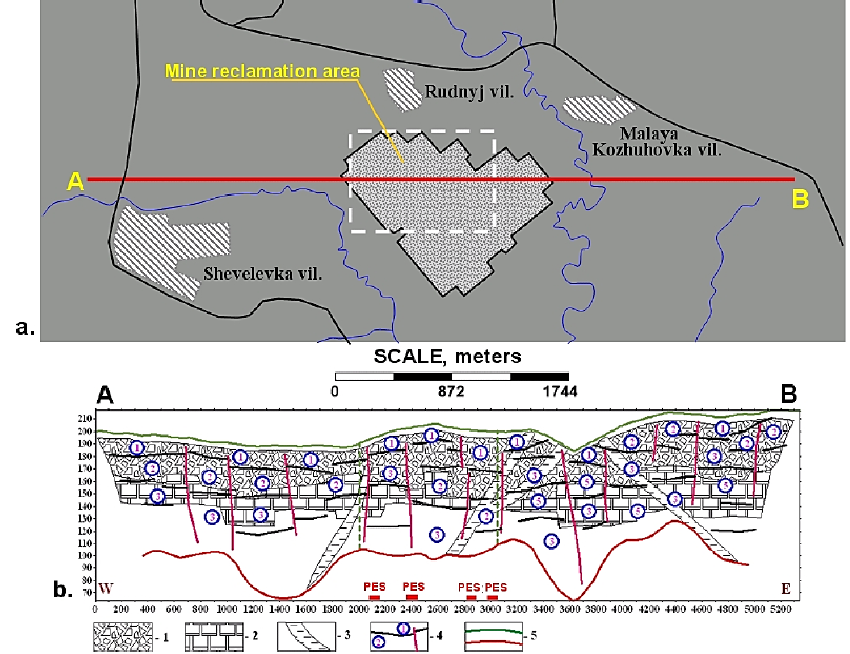
Figure 6. The example of leading deep geostructural reconstruction along AB profile: ( a ) geographical reference of AB profile with regard to the boundaries of the area of interest; ( b ) image of geostructural reconstruction in vertical cross-section plane. The legend: 1,2 — stratification elements; 3 — through zones of increased permeability of geological environment; 4 — interfaces (black — bedding, pink — fracture) and layer numbering; 5 — roof and subface of reconstruction (green — the Earth ’s relief, red — deep level of hydrostatic compensation of the Earth ’s relief). The vertical green dotted line marks the boundaries of the area of interest. In the lower part of the section, the positions of PES zones are marked according to Figure 5c in projection on the AB profile. The scale of vertical and horizontal axes is defined in meters.